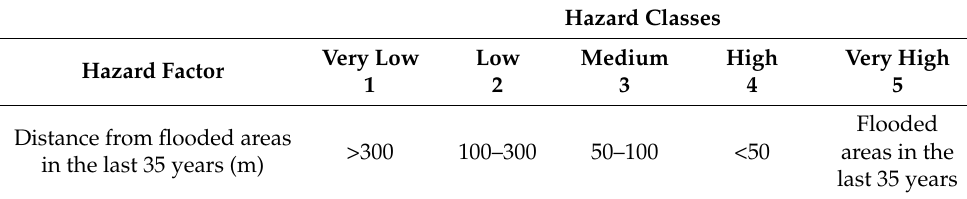
Table 2. Hazard classification concerning the distance from flooded areas in the last 35 years hazard